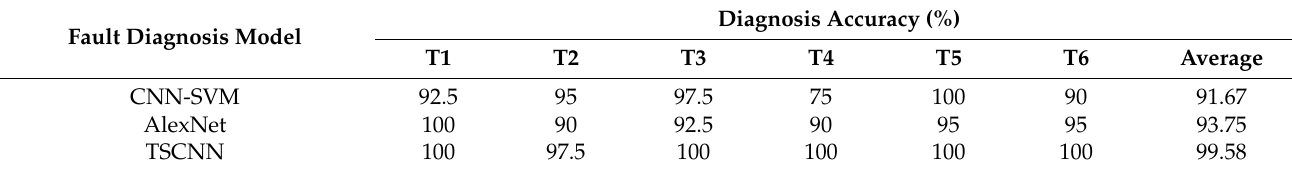
Table 5. Results of different bolt-loosening faults based using the proposed TSCNN compared with CNN-SVM and AlexNet.